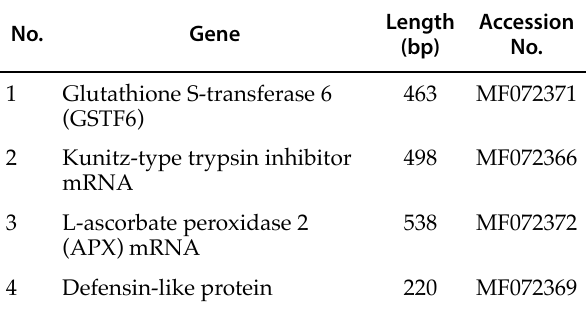
Table 6. Nucleotide sequences of selected bands from the differential display-PCR.